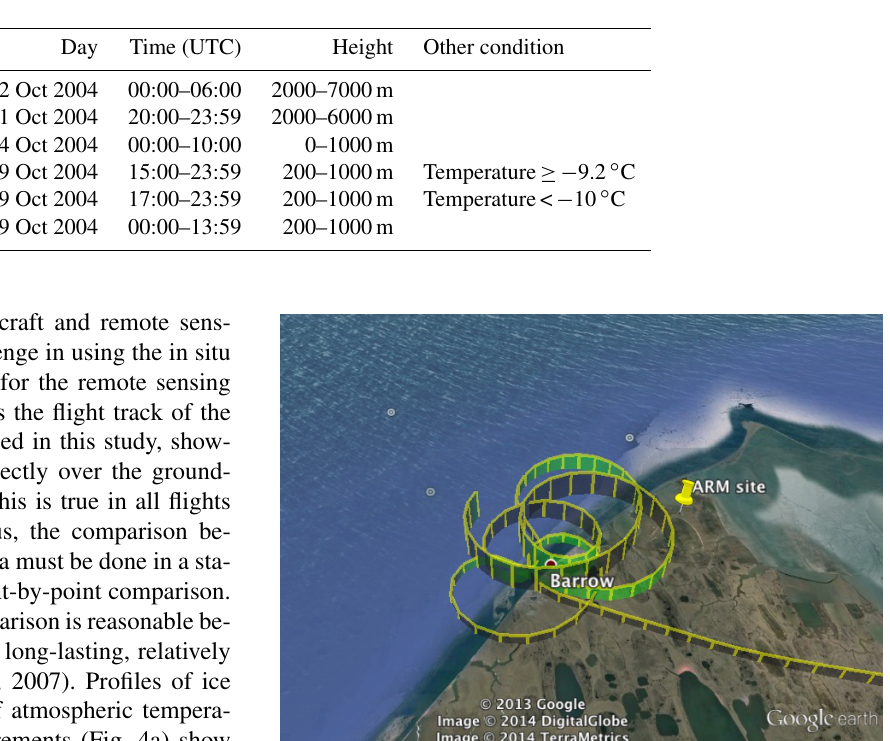
Table 1. Time, height, and temperature thresholds defining data used to train the model.